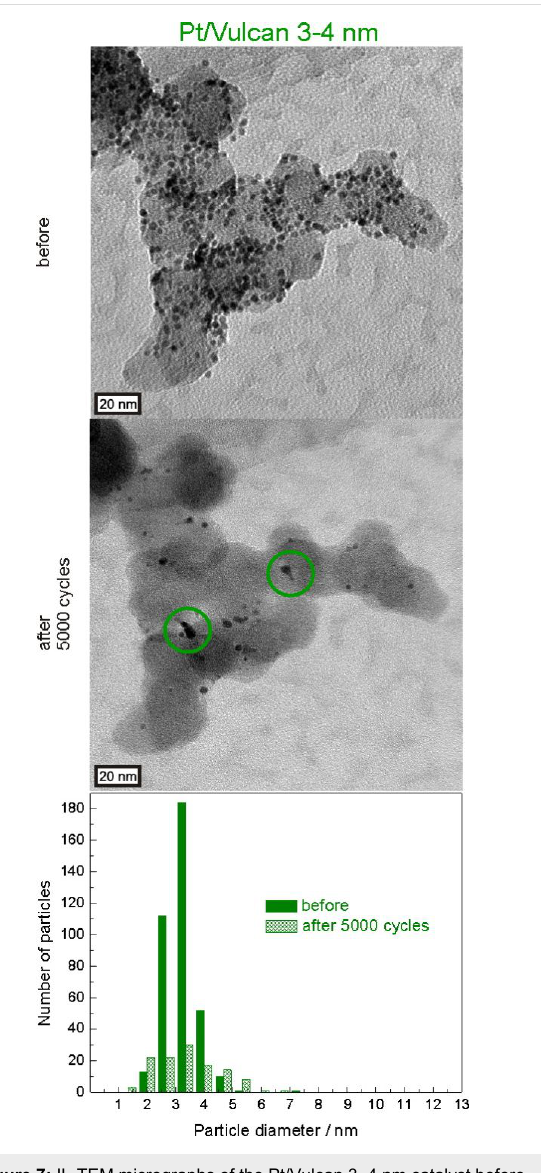
Figure 7: IL-TEM micrographs of the Pt/Vulcan 3–4 nm catalyst before and after 5000 potential cycles between 0.4 and 1.4 V RHE in 0.1 M HClO 4 (scan rate 1 V·s − 1 , room temperature). Green circles indi- cate examples for agglomeration of platinum nanoparticles. The particle size distributions before and after 5000 degradation cycles indicate both particle growth and dissolution to occur. Bars referring to the same particle diameter before (filled) and after degradation (shaded) are pictured next to each